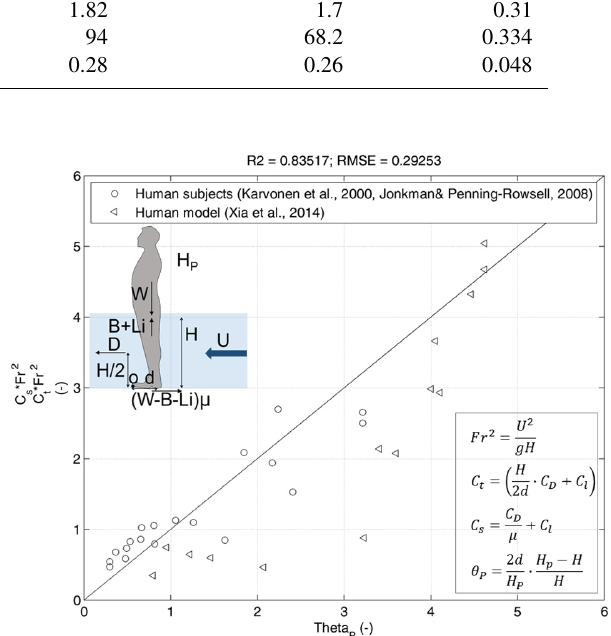
Figure 6. Normalized moment against Froude number for the four human subjects (Karvonen et al., 2000; Jonkman and Penning- Rowsell, 2008) and the human model (Xia et al., 2014).